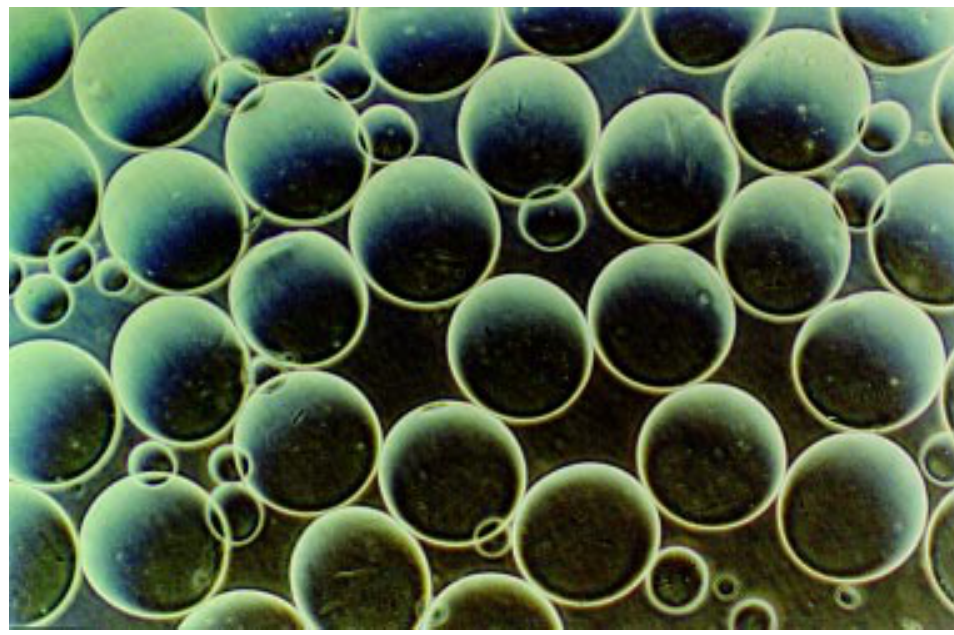
Figure 2. Biodritin capsules of 400-600 µm in diameter. Magni- fication